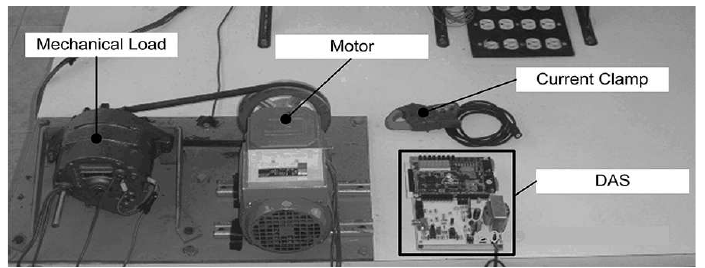
Figure 2. Experimental setup.